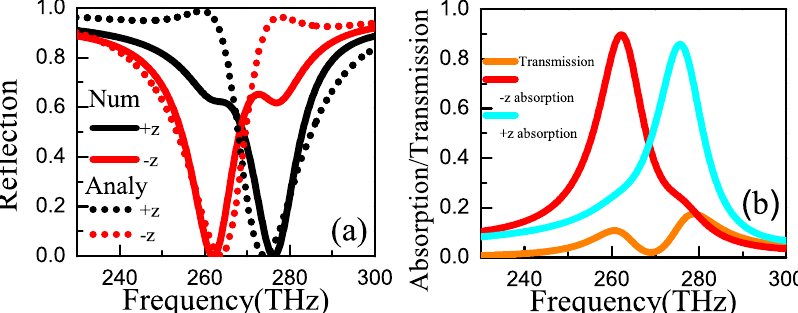
Figure 2. (Color online) ( a ) Numerical simulation (Num) and analytical calculation (Analy) on reflection spectra as the function of frequency ω when s = 275 nm and incident angle θ = 0 ◦ . ( b ) Absorption and transmission spectra as the functions of frequency ω . The parameters are γ 1 = 3.209 THz, γ 2 = 2.150 THz, Γ 1 = 8.503 THz, Γ 2 = 8.803 THz, ϕ = 0.967 π and κ = 1.765 THz.